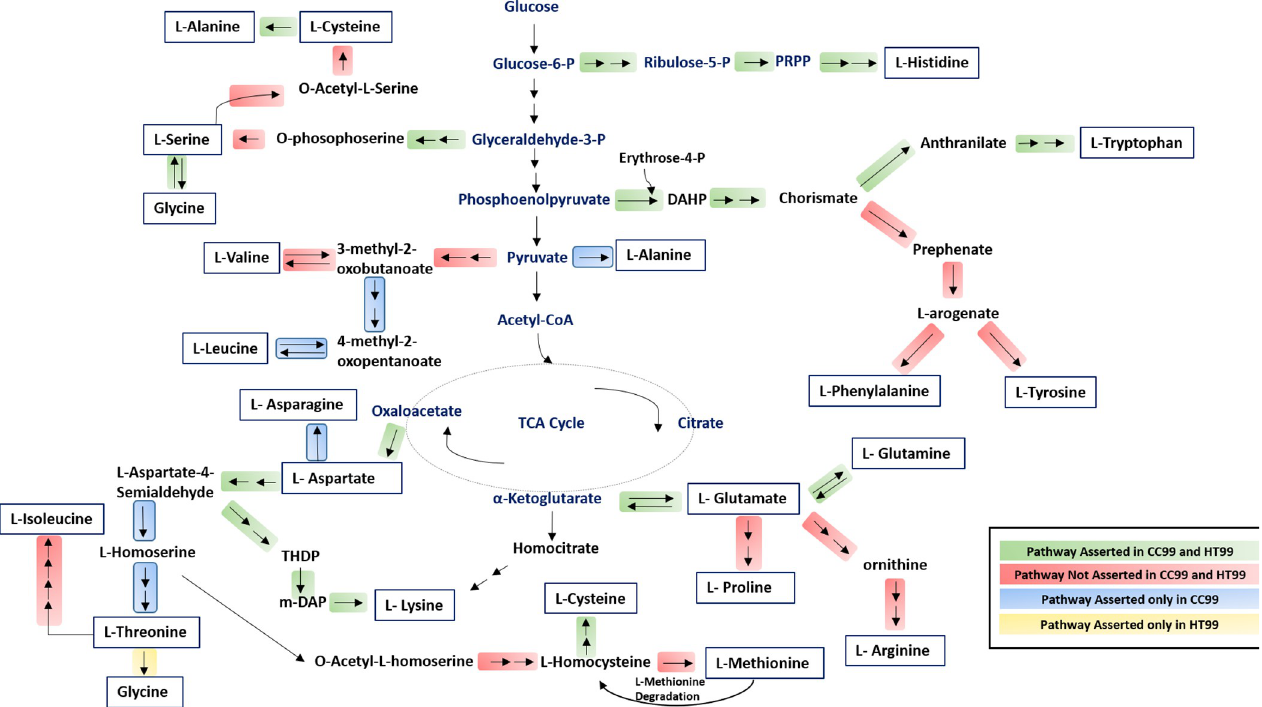
Fig 4. Amino acid biosynthesis pathways of “ Ca . B. cookevillensis” (CC99) and “ Ca . B. aquae” (HT99). Genome inferred amino acid pathways appear to be reduced in both bacteria. Only 11 of the 20 amino acid pathways could be asserted for CC99 while only 8 could be asserted for HT99.